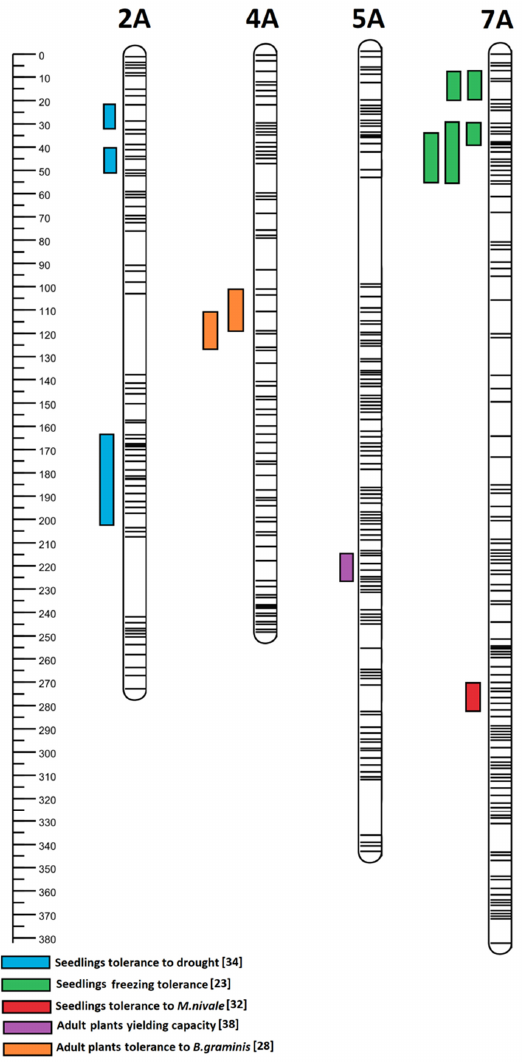
Figure 1. Subgenome A regions identified for the winter triticale DH ‘Hewo’ × ‘Magnat’ mapping population, related to the seedling tolerance to drought, freezing, and pink snow mold caused by M. nivale as well as the tolerance of adult plants to powdery mildew and yielding capacity in the generative phase. Subgenome regions were determined by bioinformatics using the genetic map published by Tyrka et al. [21] and Windows QTL Cartographer V2.5_011.